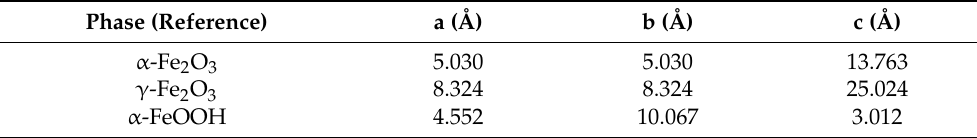
Table 4. Table of reference lattice